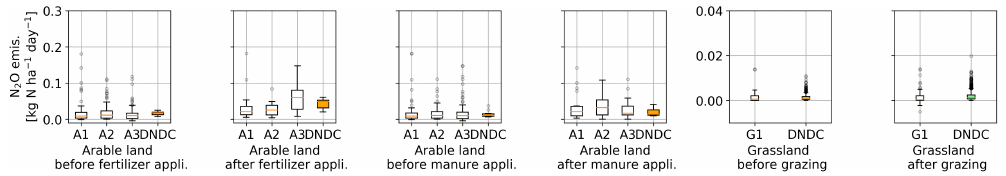
Figure 4. Management effects on N 2 O emissions. Measured and modelled emissions within a time window of 2 weeks before and 2 weeks after a management